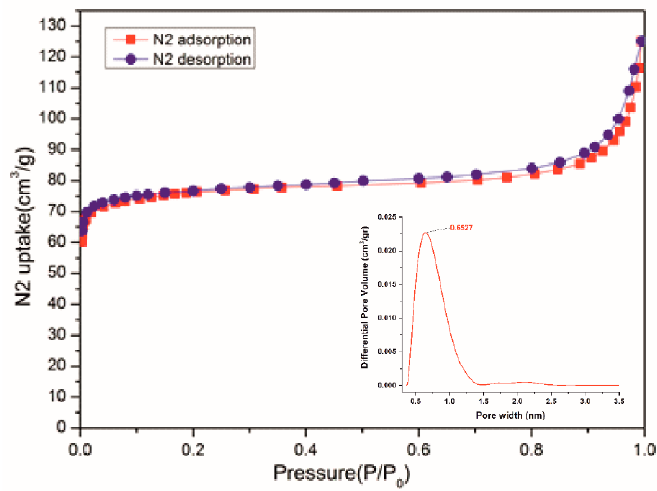
Figure 4. N 2 adsorption isotherm at 77 K for activated 1 ′ -CH 2 Cl 2 -air. The inset shows the calculated pore-size distribution using a 2D-NLDFT Heterogeneous Surface model.